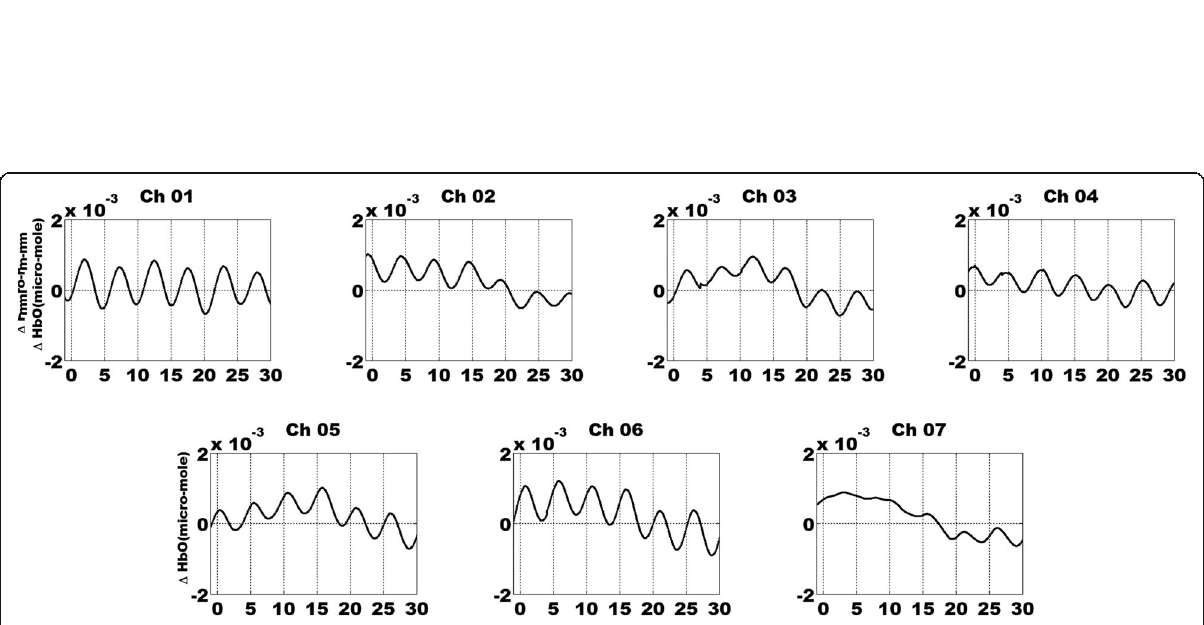
Fig. 2 Configuration of fNIRS probes. Red and blue dots denote the laser sources and detectors, respectively. The connection between each laser source and detector is the channel